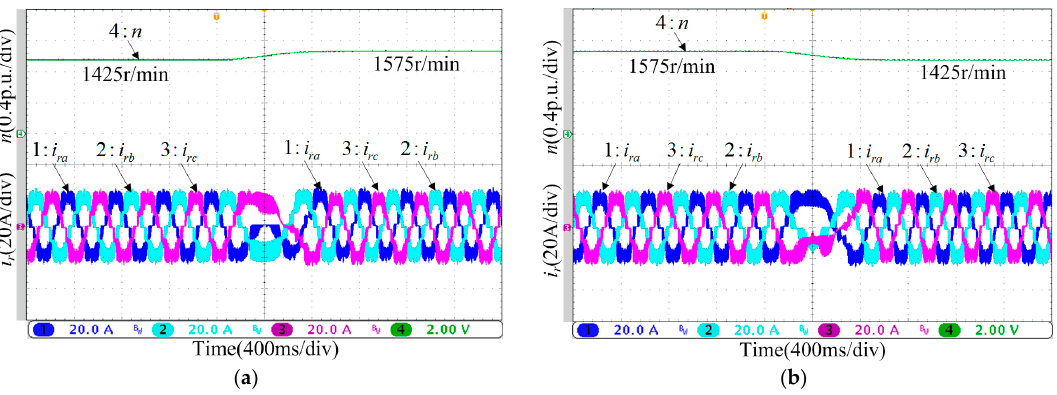
Figure 10. Experimental results of the doubly-fed, adjustable-speed, pumped storage hydropower experimental platform. ( a ) Sub-synchronous to super-synchronous; ( b ) Super-synchronous to sub-synchronous.